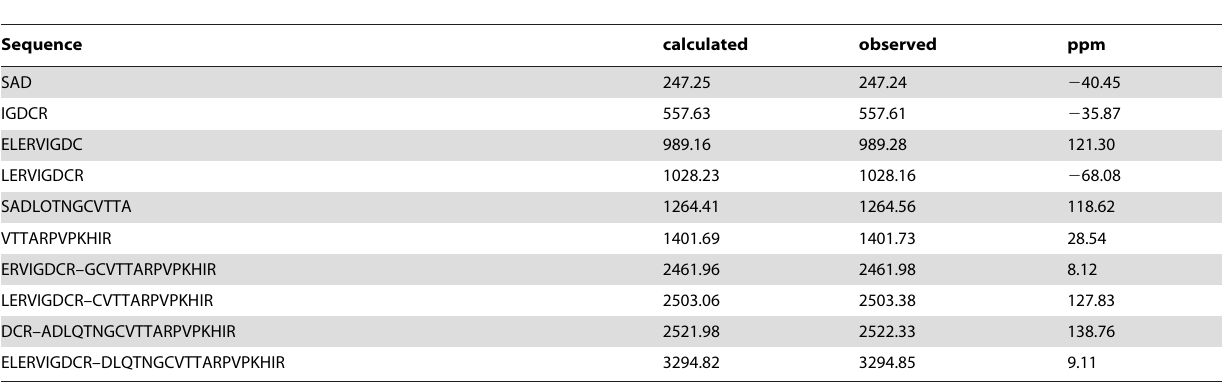
Table 3. Sequences for Cys32-Cys250 peptide fragments at 3451.17 (m/z) analyzed by MALDI-TOF-MS/MS.